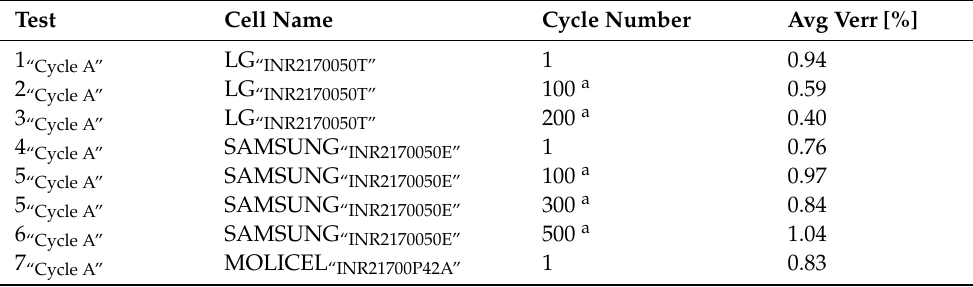
Table 2. Average output voltage error of the reference